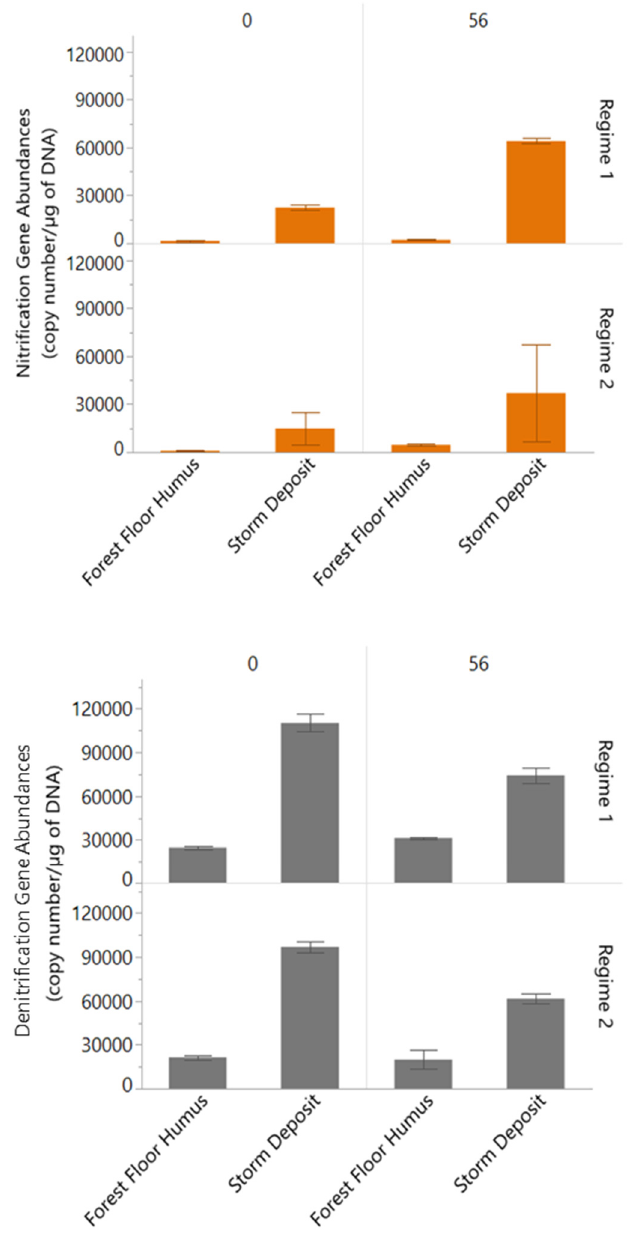
Figure 9. Comparison of initial (day 0) and final (day 56) nitrification and denitrification gene abundances (copy number/ µ g of DNA) for forest floor humus and storm deposit by moisture regimes. Nitrification genes are the sum of AOA and AOB (top) and denitrification genes are the sum of nir S and nir K (bottom). Bars and error bars denote gene abundance means and standard deviation.